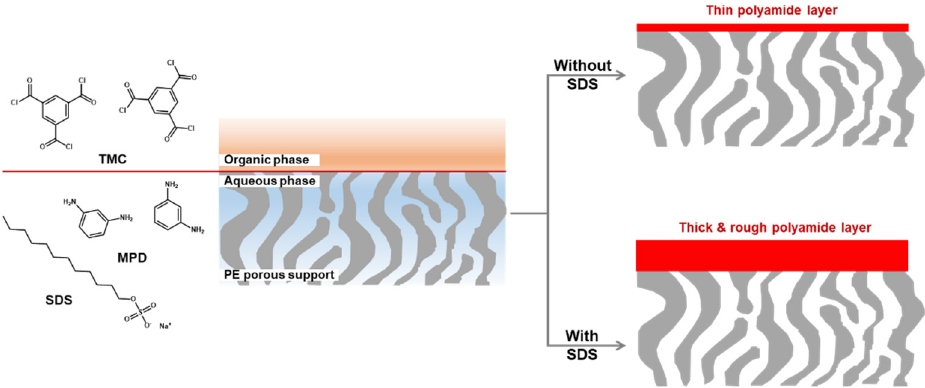
Figure 3. MPD-based polyamide selective layer on top of polyethylene (PE) porous support mem-